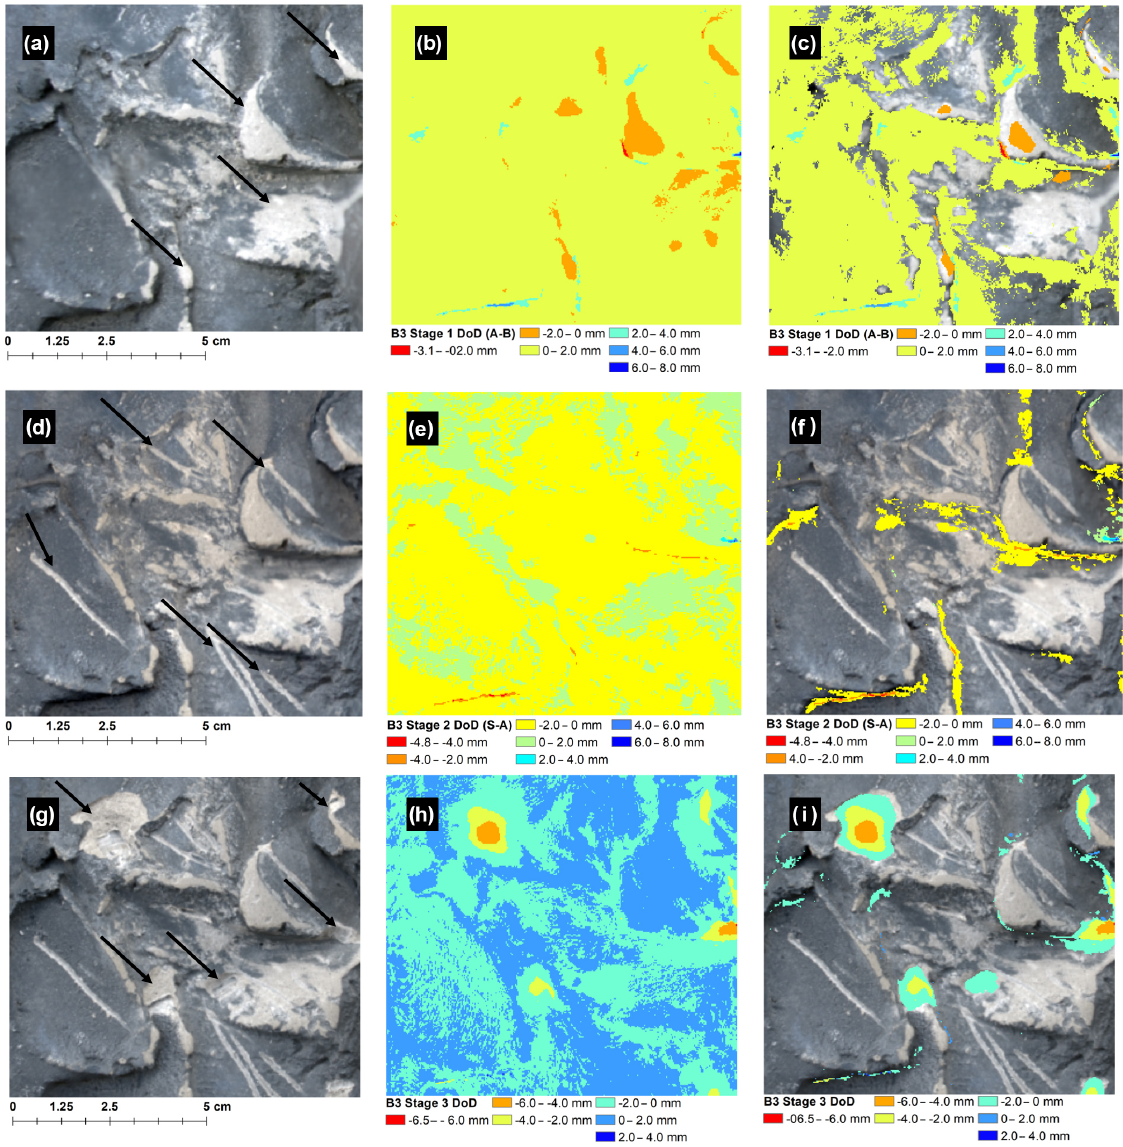
Figure 6. (a) B3 Stage 1 orthophoto showing abraded surface area (light grey) of simulated platform surface. (b) DoD for B3 Stage 3 before thresholding and (c) DoD at LoD shown at 50% transparency overlaid onto the orthophoto shown in (a) . Note significant geomorphic change detected in shadow zones where no change is expected. (d) B3 Stage 2 orthophoto showing the scratched surface of the simulated platform (black arrows), (e) DoD before thresholding, and (f) DoD thresholded at LoD. As in (c) , note the change higher than the LoD detected in shadow zones in (f) where no change is expected. (g) B3 Stage 3 orthophoto showing the location of percussions (black arrows), (h) B3 Stage 3 DoD before thresholding at LoD, and (i) B3 Stage 3 DoD thresholded using calculated LoD. Note shadow zones where DoD indicates change, but none is